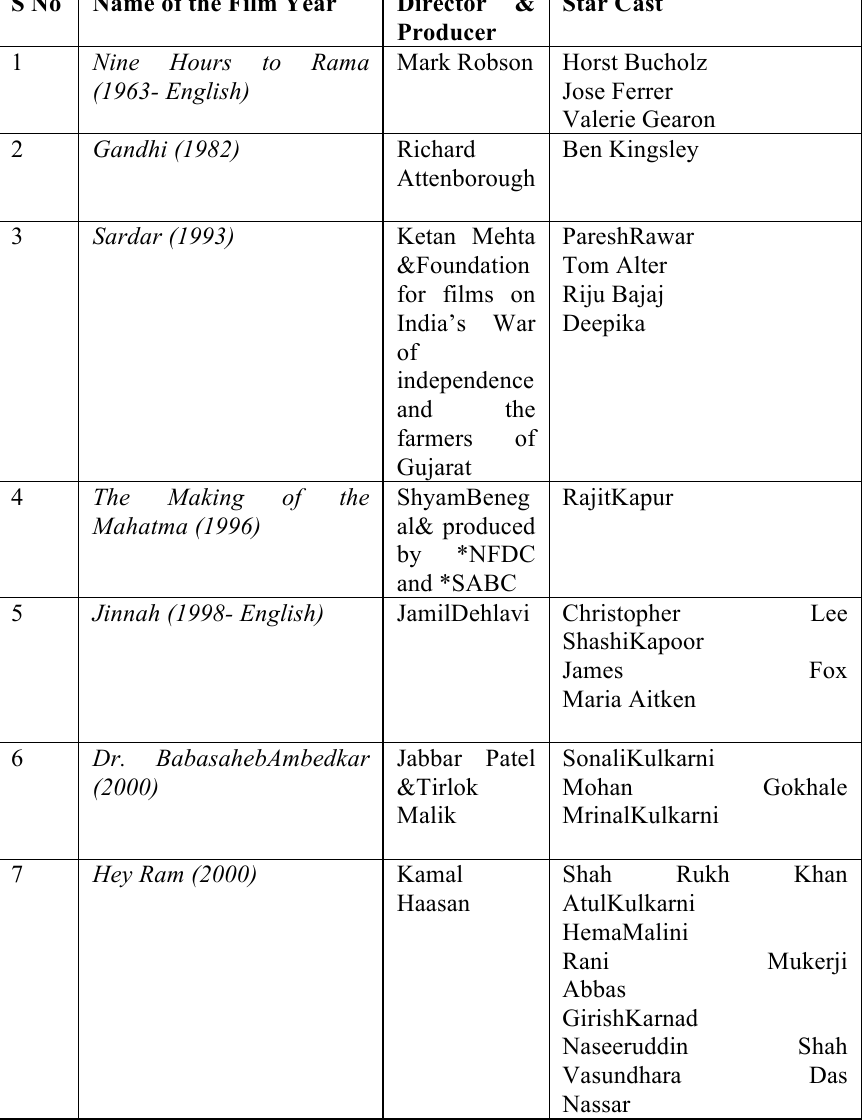
Table: 1. Details of films under